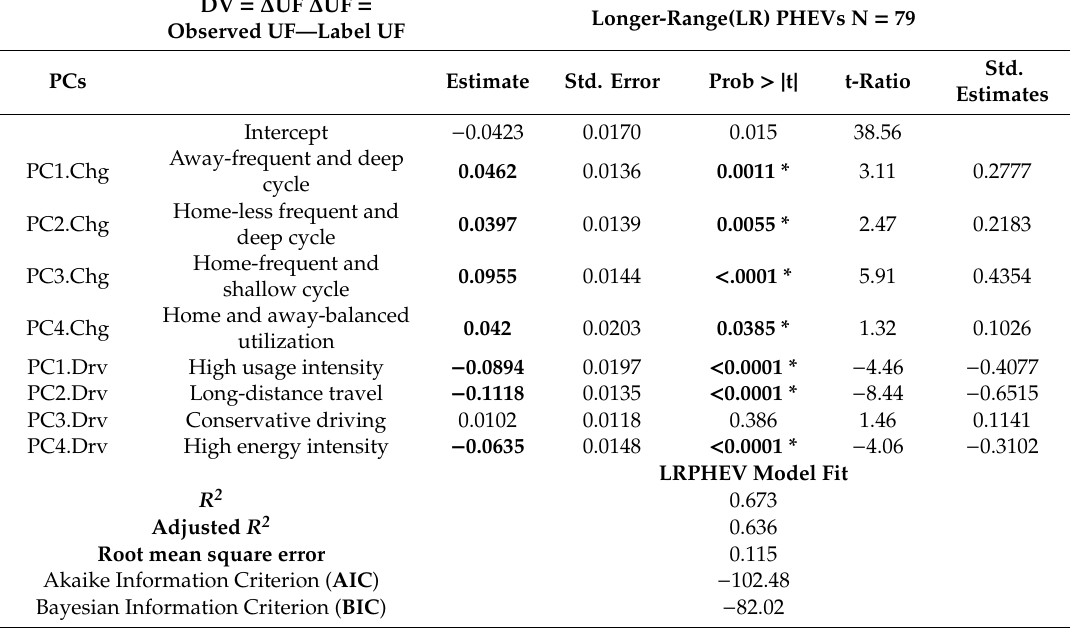
Table 10. OLS Regression Model Results: Long-range PHEVs (LRPHEVs).